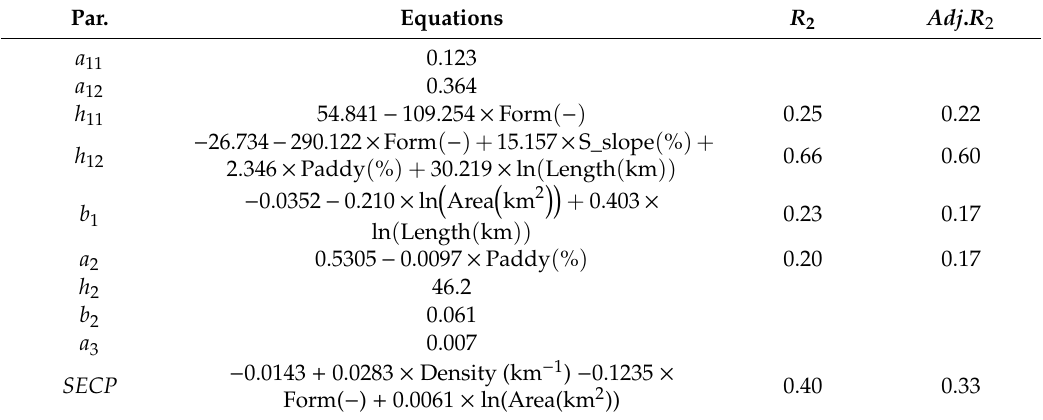
Table 4. The 3-Tank model parameters regionalized based on the results of calibration implemented with optRMSE .